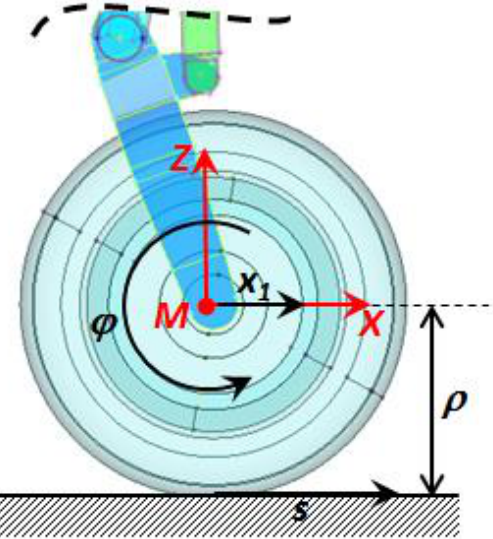
Figure 3. Graphical sketch explaining relationships among variables s , x 1 , and ϕ . As a whole, Equations (5)–(7) define the system of nonlinear and coupled differential equations whose solution describes the impact dynamics of the landing gear in terms of the time-dependent state variables x 1 , z 1 , z 2 , and ϕ